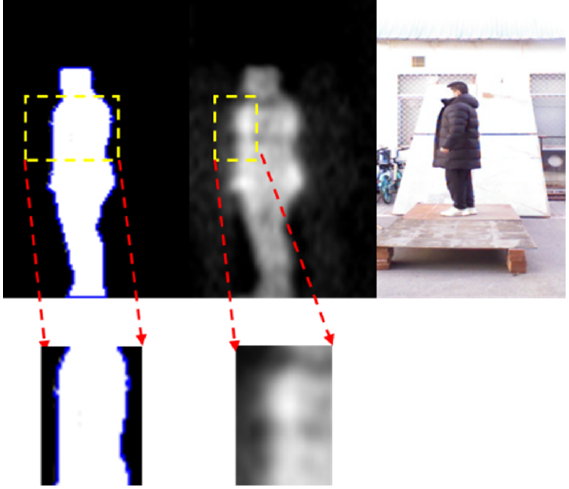
Figure 19. Example of a failure case, where the small size threats cannot provide sufficient contour